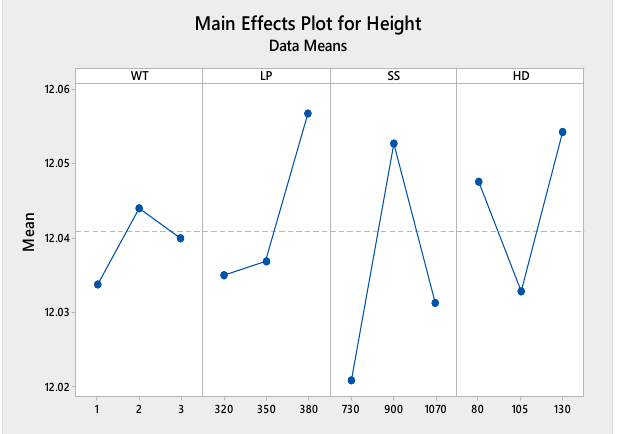
Figure 10. Main effects plot for height.